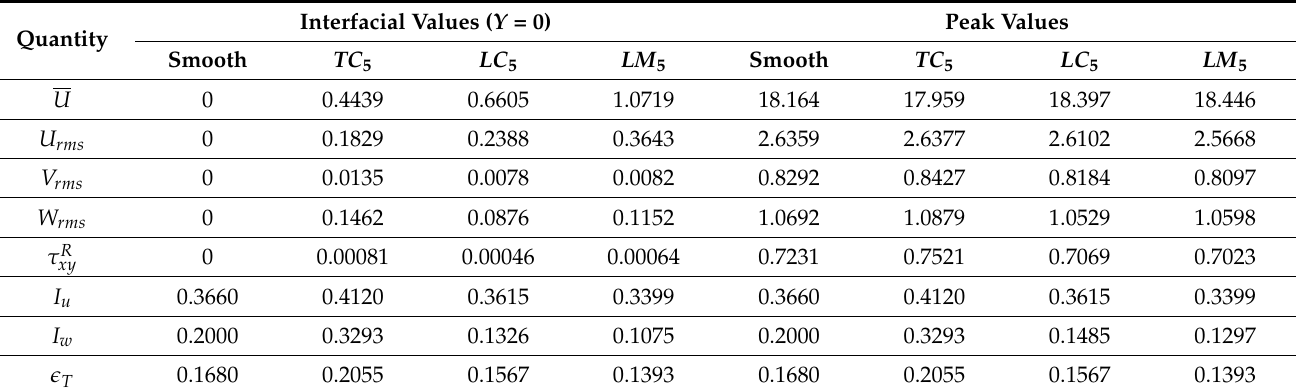
Table 4. Interfacial and peak values of the mean velocity and of turbulence-characterizing parameters for different configurations of the porous medium ( θ = 0.5 and (cid:101) = 0.05). The peak values are those closer to the permeable surface. For reference, also the results for a smooth channel are